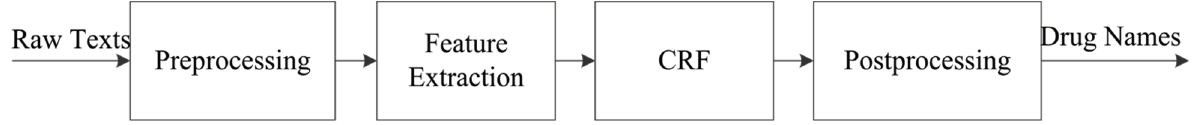
Figure 1. Architecture of our conditional random fields (CRF)-based DNR